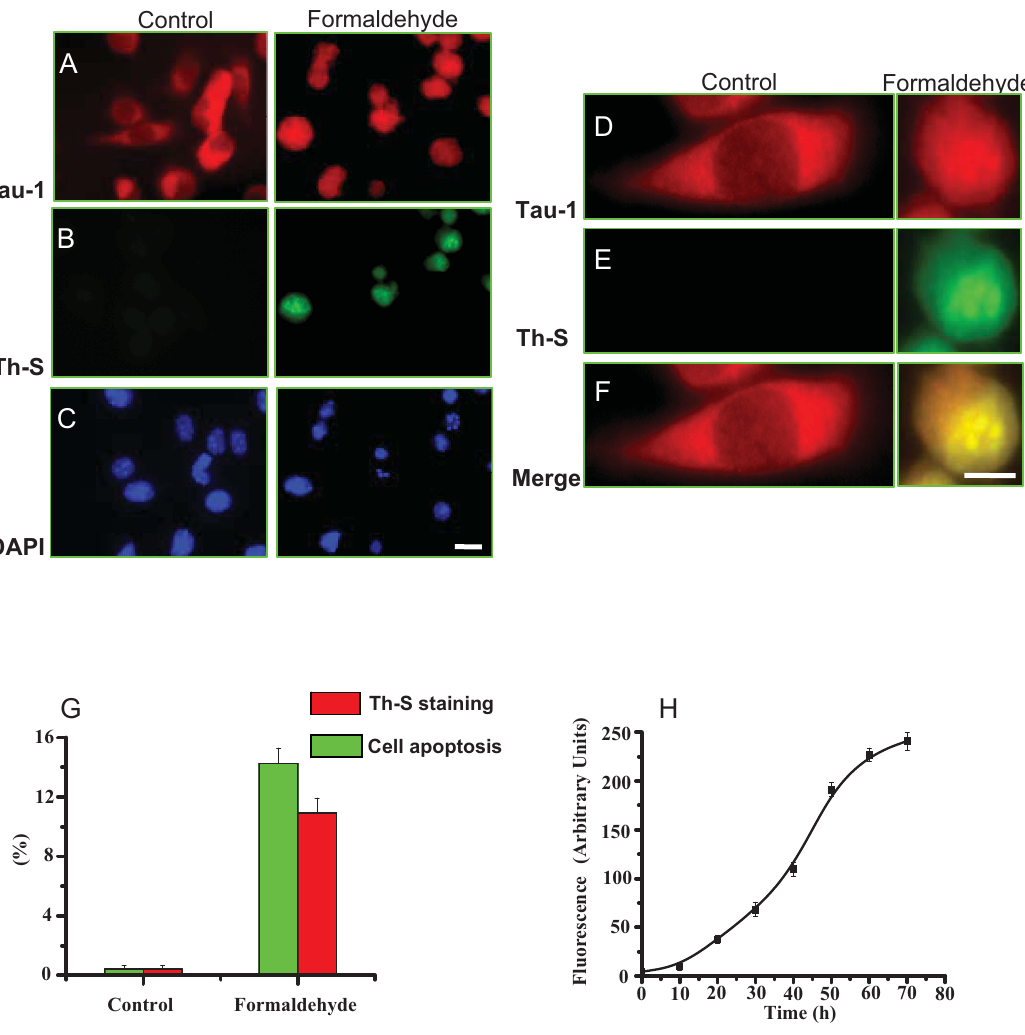
Figure 9. Tau aggregation in SY5Y cells in the presence of formaldehyde. SY5Y cells were cultured and incubated with 0.0005% formaldehyde for 72 h. Immunolabelling with the monoclonal antibody Tau-1 was used to visualize tau expression ( A ) and thioflavin S was to detect tau aggregates in the cells ( B ). Cells stained with DAPI showed apoptotic cells with the shrunk nuclei ( C ). Bar: 50 m m. D–F (magnified from A and B , Bar: 25 m m) show that the signals of ThS (amyloid-like aggregates) and the monoclonal antibody Tau-1 overlap each other in the cells. Quantitative results of protein tau aggregation and cell apoptosis are shown in G . Fluorescence intensity of tau aggregation stained by ThS during time course is shown in H .